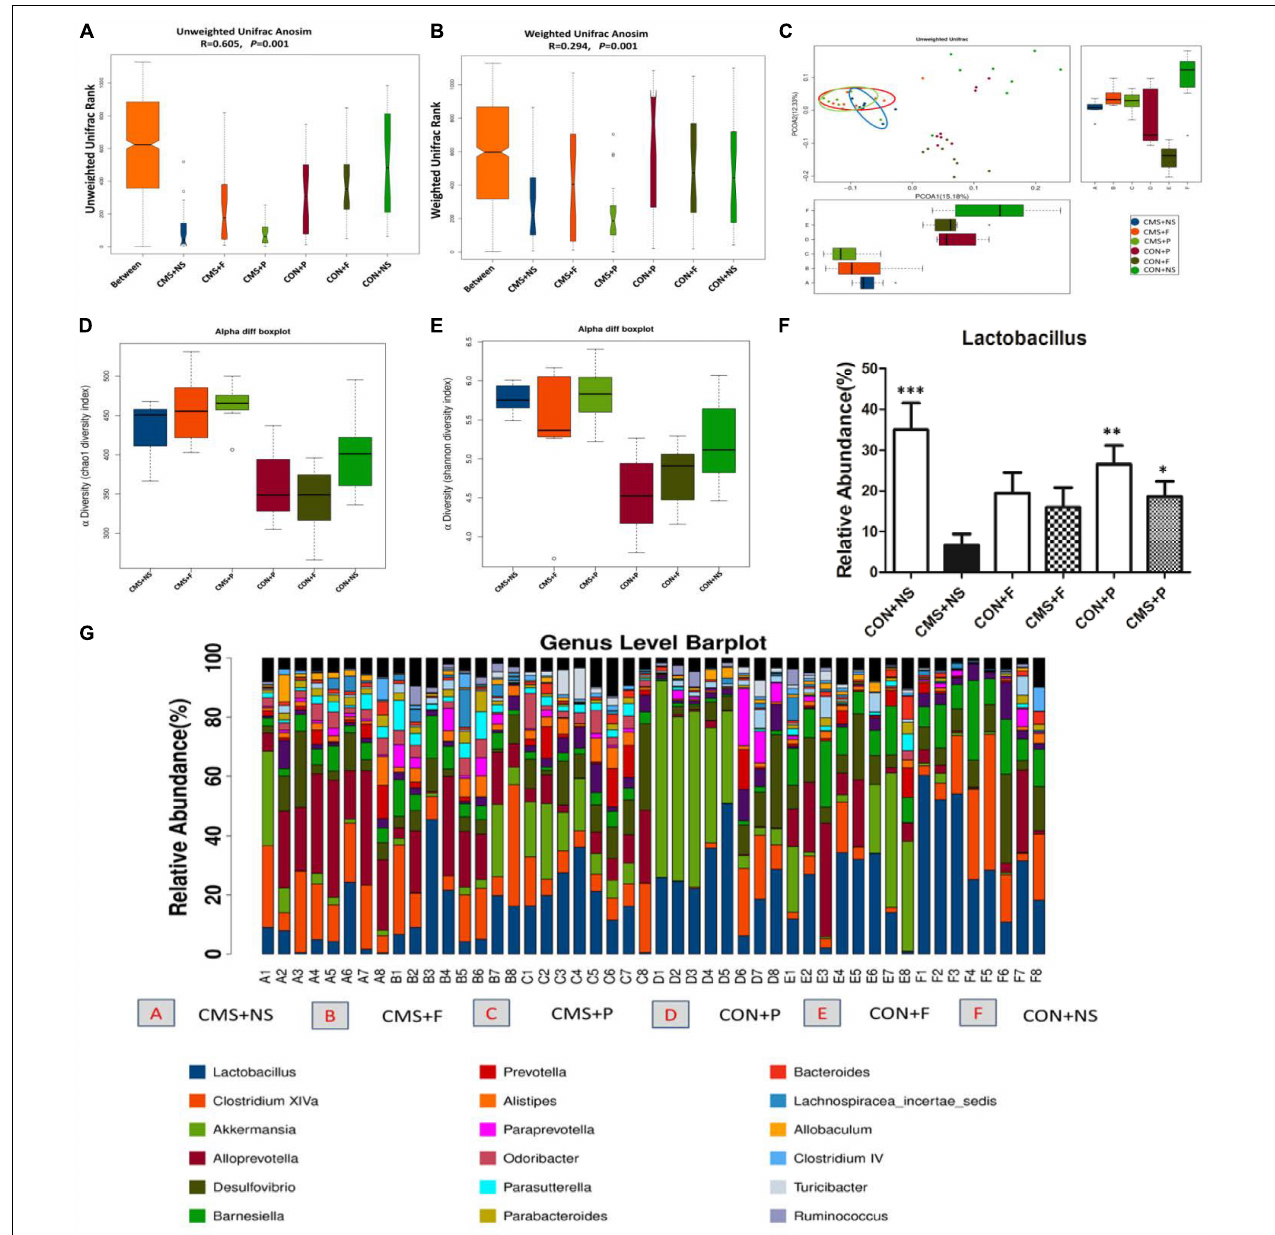
FIGURE 3 | Alterations of gut microbiota. (A) Unweighted UniFrac Anosim was significantly different among groups. (B) Weighted UniFrac Anosim was significantly different among groups. (C) Two-dimensional principal coordinate analysis (PCoA) of unweighted UniFrac distances showed a clear difference in the microbial community compositions between the stress and non-stress groups. (D) The α -diversity index, Chao1 revealed differences in species richness; stress-exposed samples presented significantly higher diversity. (E) The α -diversity index, Simpson revealed differences in species evenness; stress-exposed samples presented significantly higher species evenness. (F) Relative abundance of the genus Lactobacillus in the six groups, ∗ P < 0.05, ∗∗ P < 0.01, ∗∗∗ P < 0.001 vs. the CMS + NS group. (G) The most abundant taxa at the genus level in all samples; n = 8 per